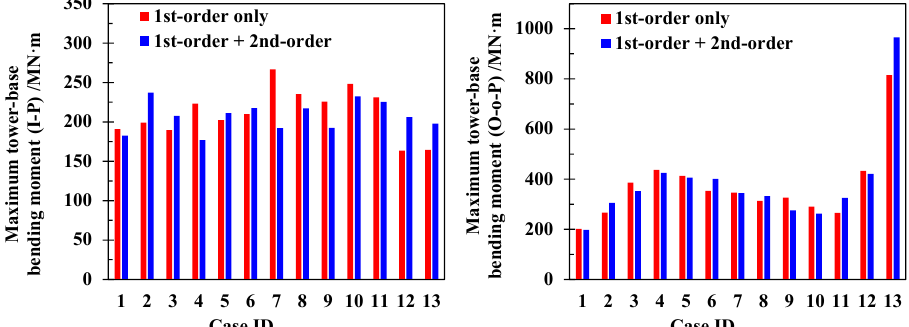
Figure 9. Maximum tower-base bending moments under all the examined load cases with and without considering the second-order wave excitations.